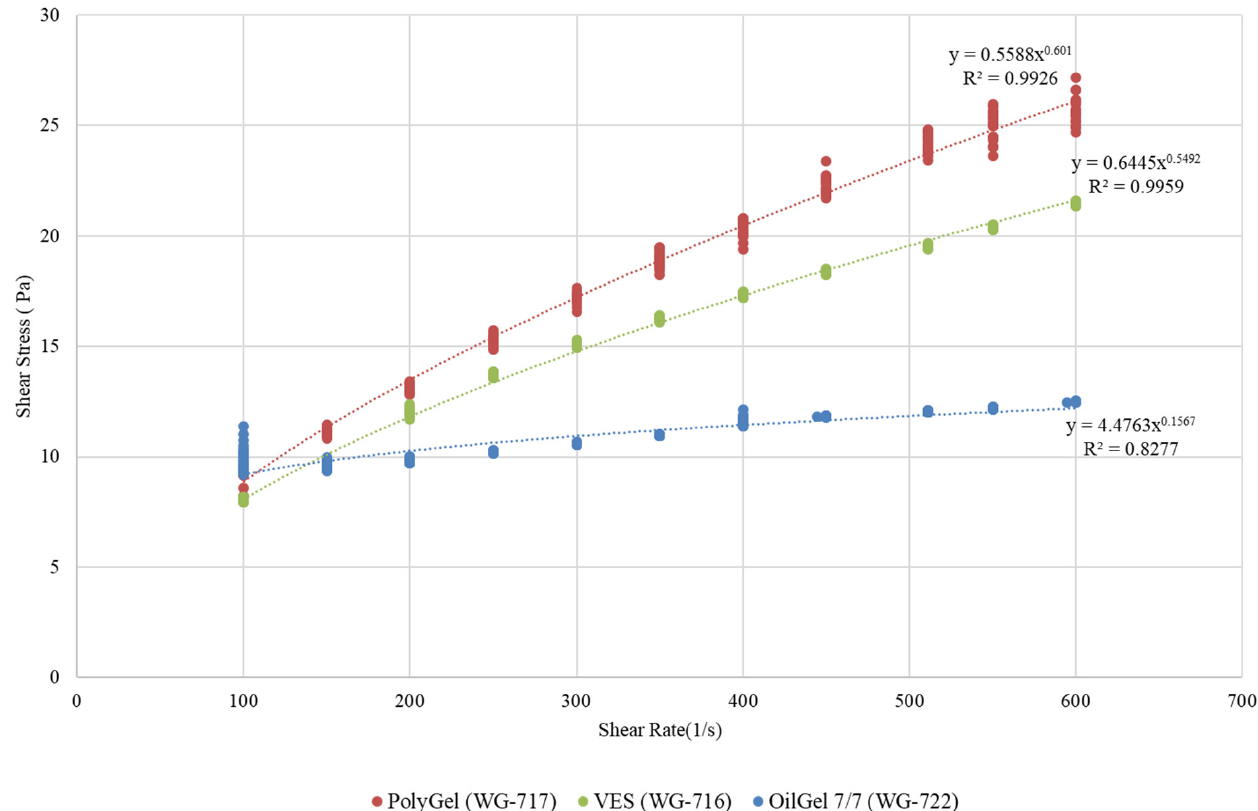
Figure 7. The dependence of shear stress on shear rate for the water-based fluids and the low viscosity oil-based fluid.